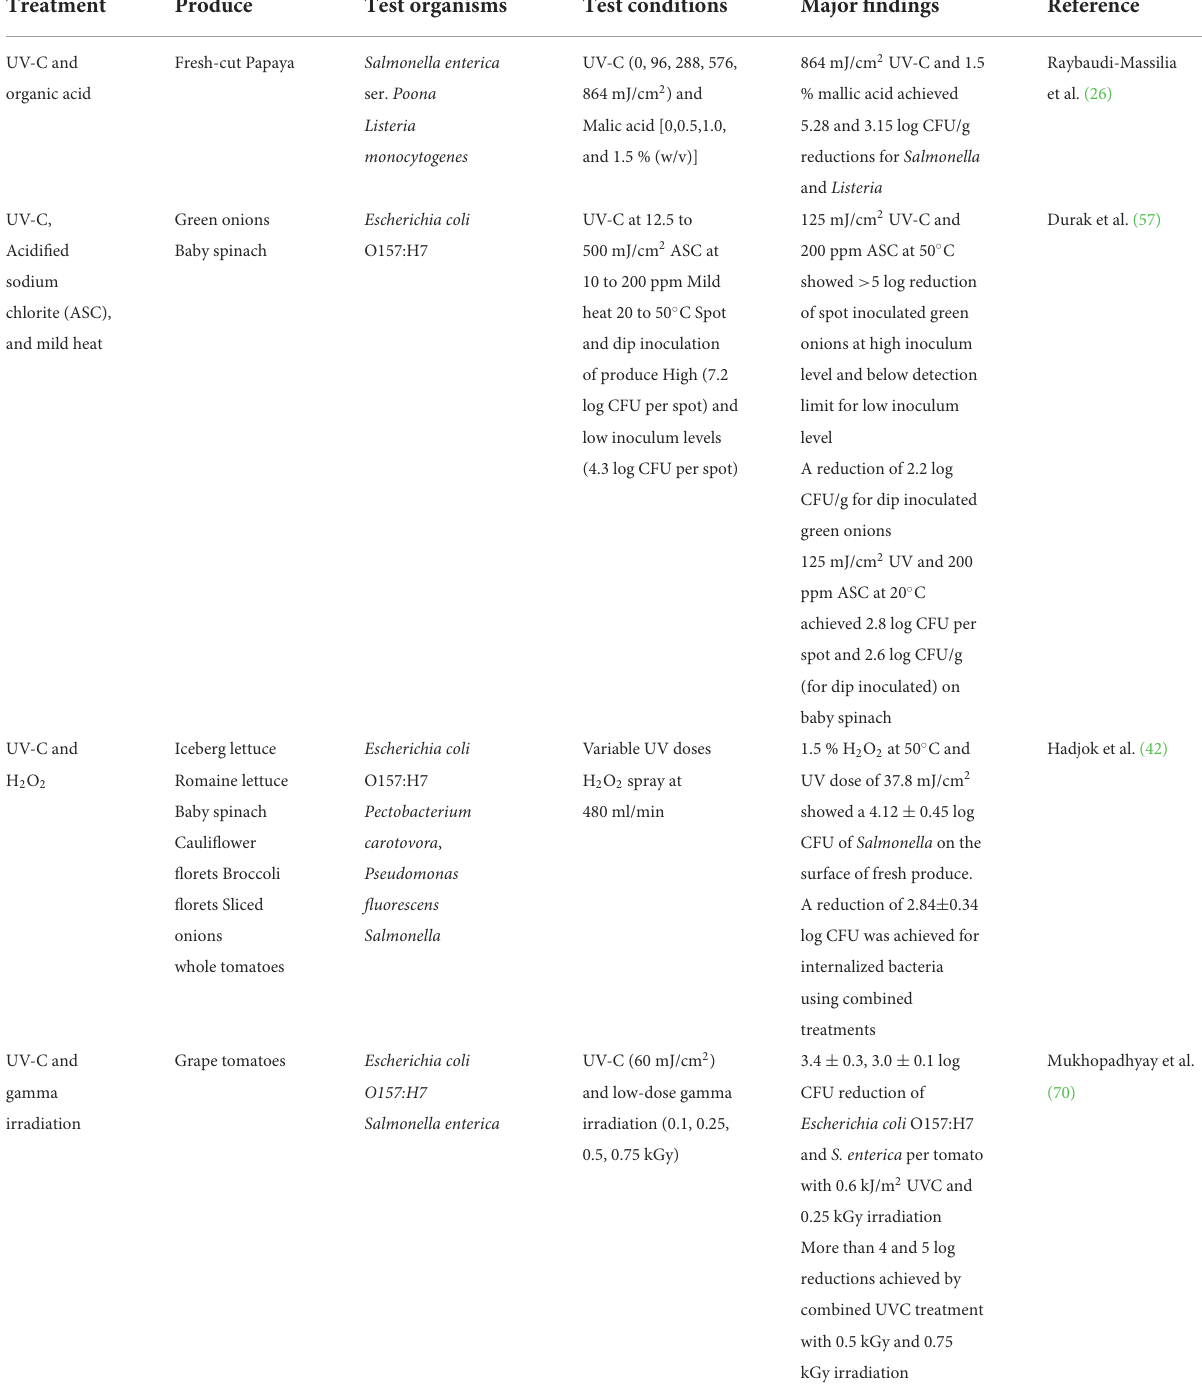
TABLE 2 UV light in combination with other